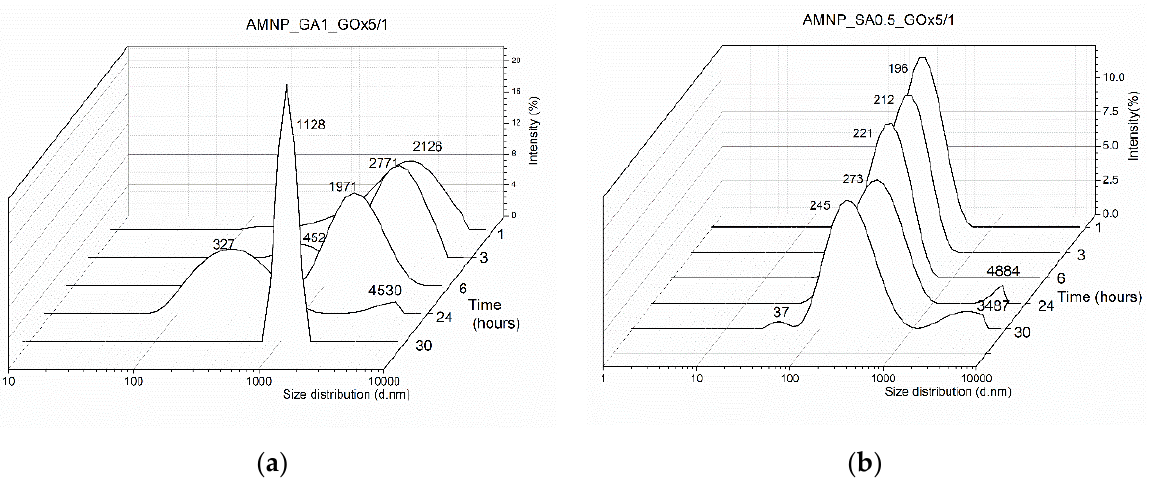
Figure 5. Size distribution reported to the GOx immobilization time of the nanoparticles: ( a ) AMNP_GA1 and ( b ) AMNP_SA0.5 in buffer solution, 0.01 M, pH 6.5 at room